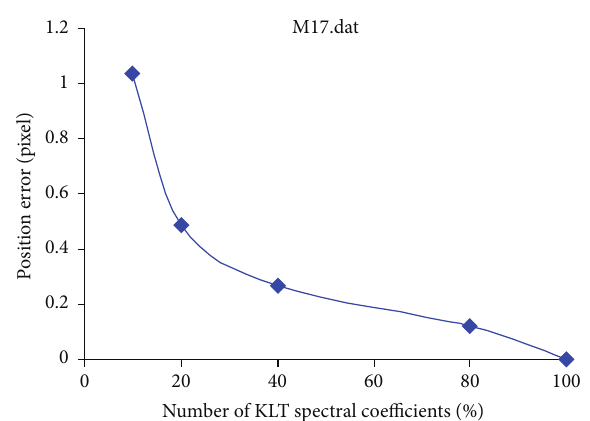
Figure 8: The object position error (astrometry measurement) as a function of number of used KLT spectral coefficients.